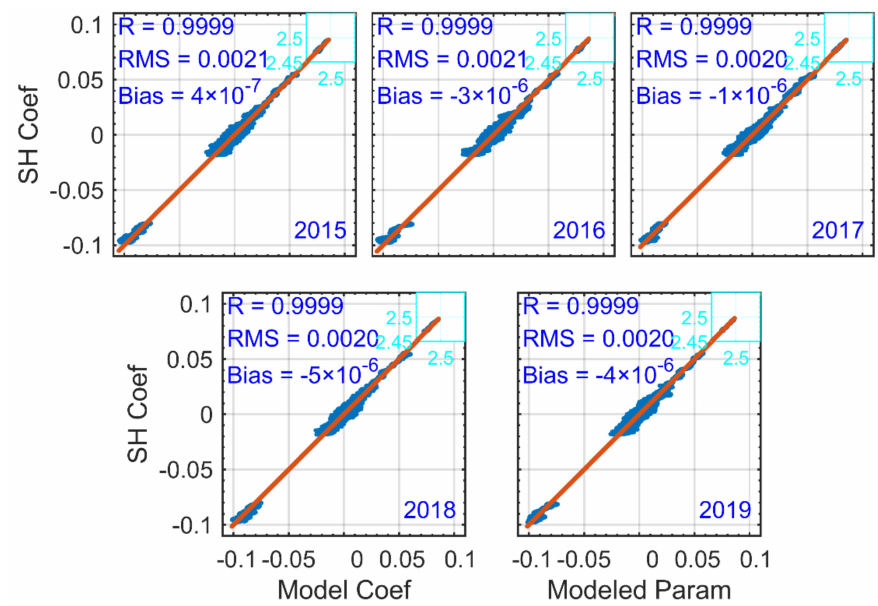
Figure 6. Scatter plots of observational data versus modeled values of SH coefficients for the period 2015 − 2019. The blue-green box shows the first spherical harmonic coefficient. The correlation coefficient (R), RMSE (RMS) and Bias (Mean) are also shown in the panels.